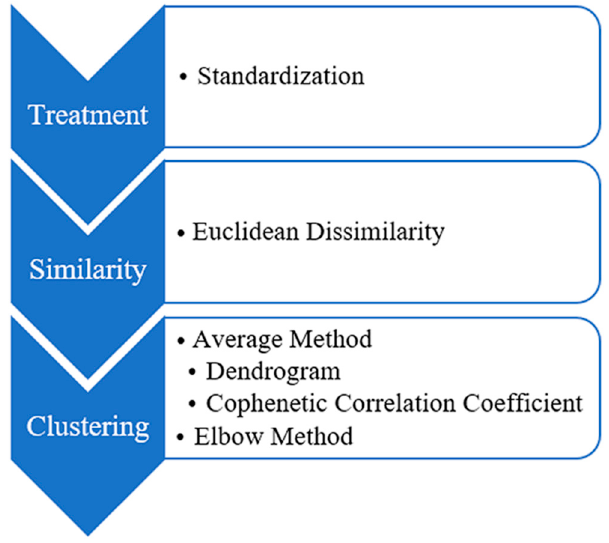
Figure 1. Clustering analysis stages.